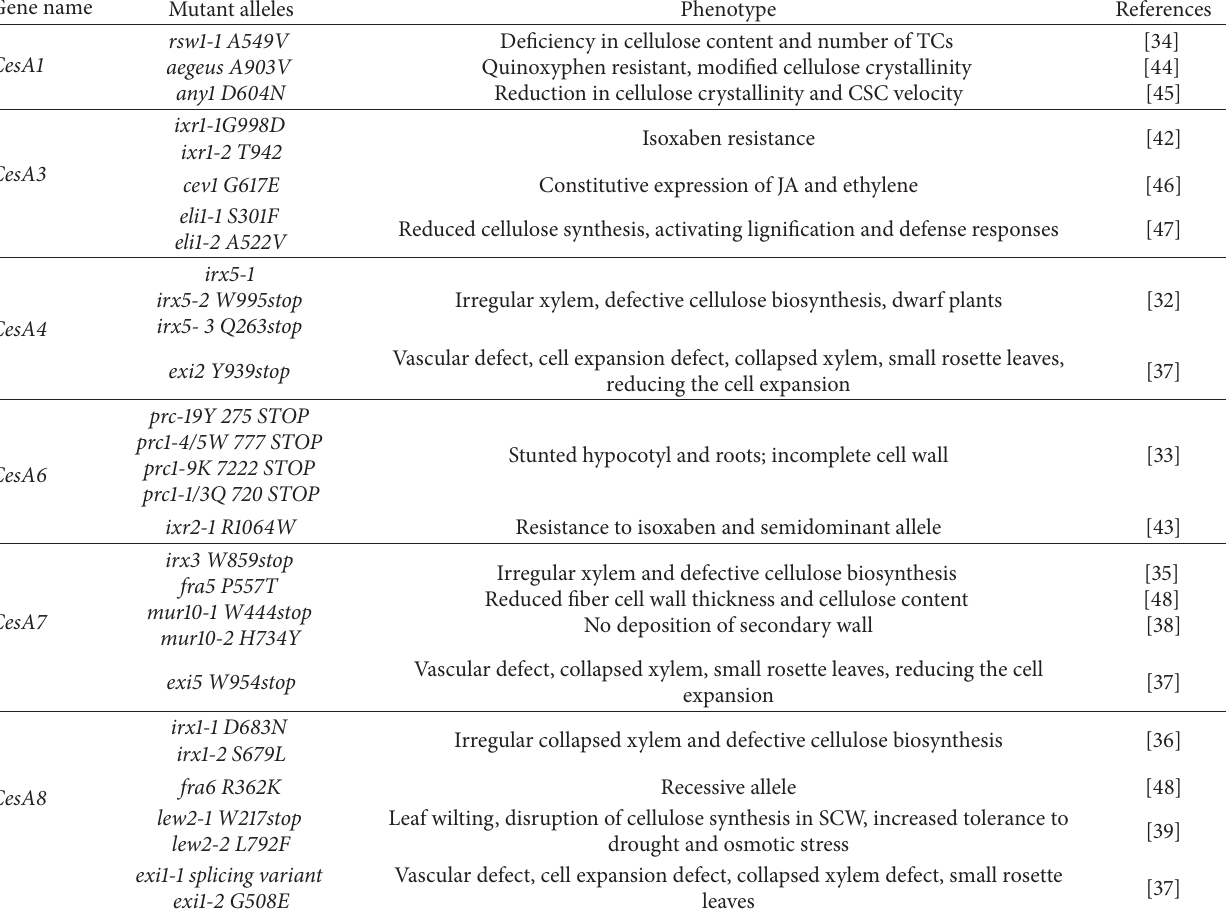
Table 1: Arabidopsis CesA mutants and their